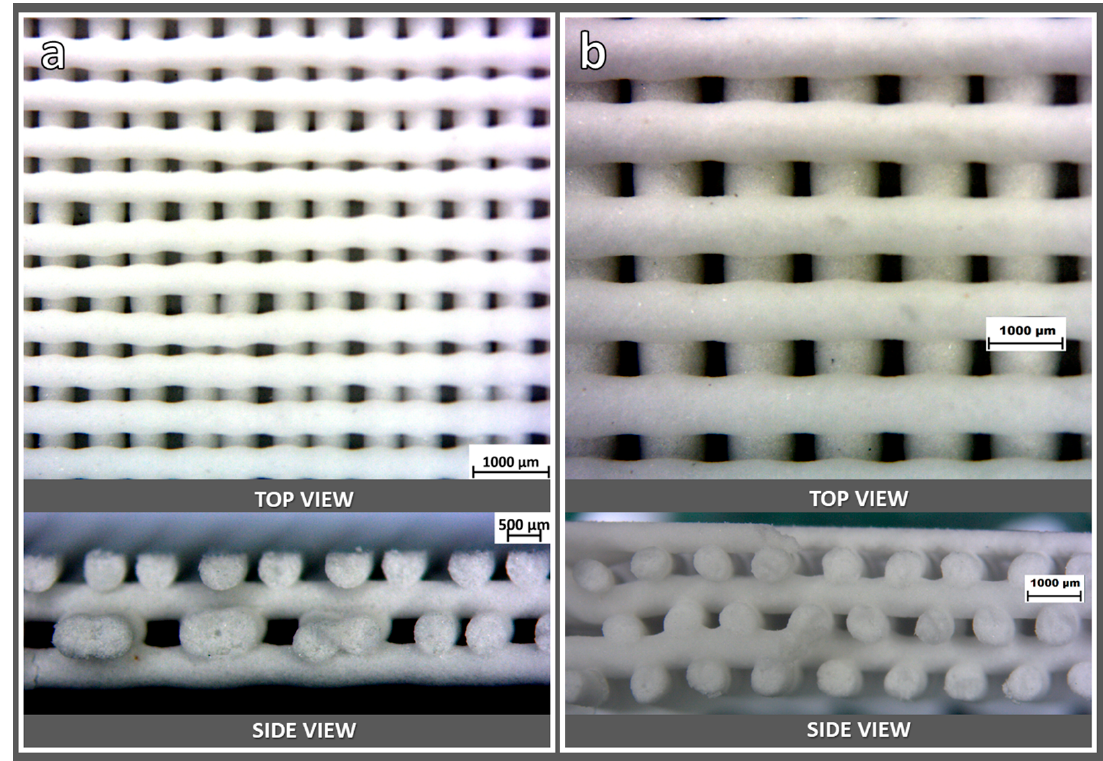
Figure 4. Optical stereomicroscopy top and side views of ‘green’ scaffolds from LCD glass, obtained by extrusion through 400 ( a ) and 800 ( b ) μ m nozzles.